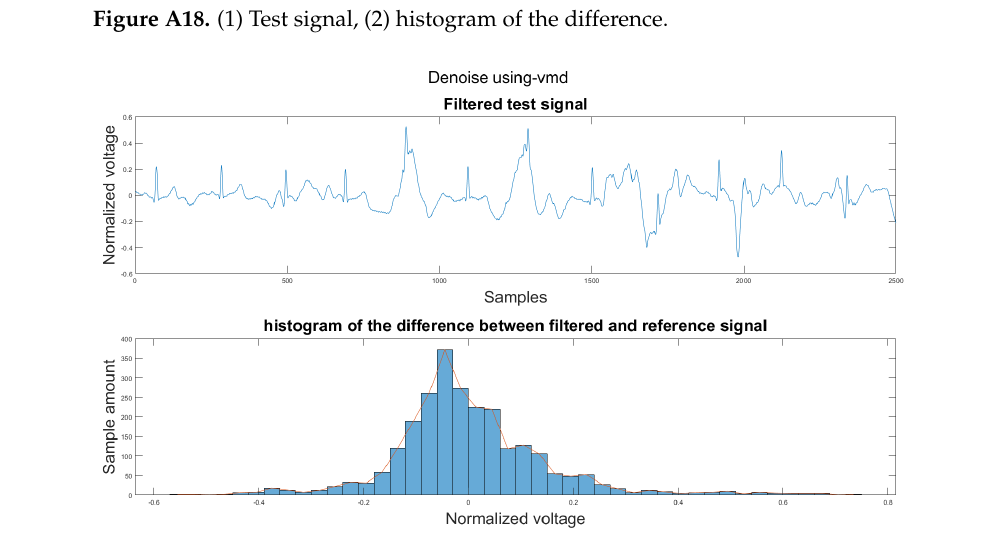
Figure A19. (1) Test signal, (2) histogram of the difference.